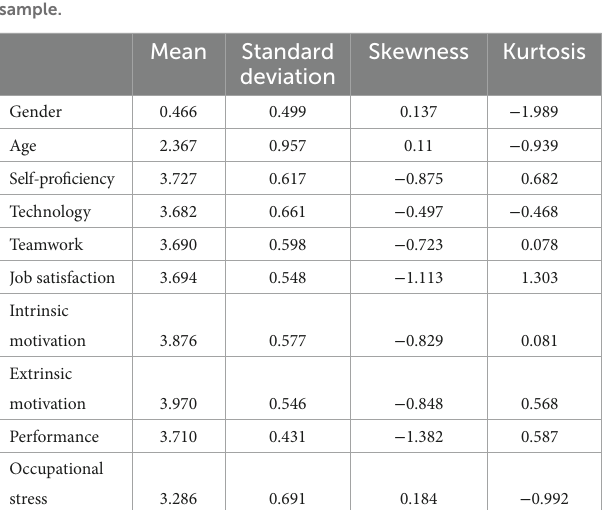
TABLE 3 Mean, standard deviation, skewness, and kurtosis of the study sample.